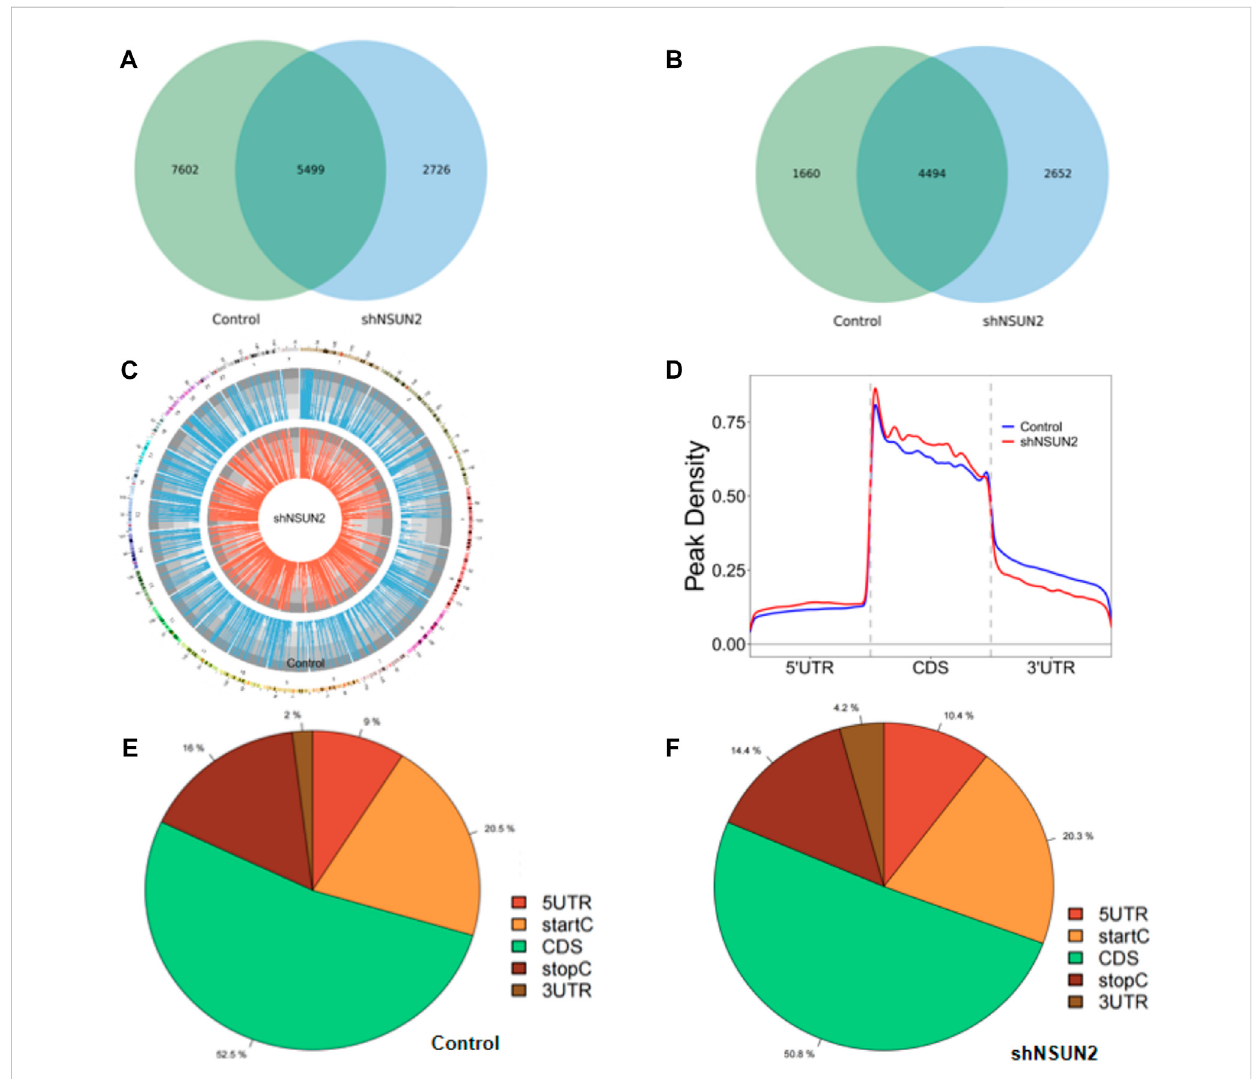
FIGURE 2 Characteristics of m5C peaks in HCT15 cell and sh-NSUN2 HCT15 cell (A) Venn diagram of m5C peaks in HCT15 cell and sh-NSUN2 HCT15 cell. (B) Venn diagram of m5C genes in HCT15 cell and sh-NSUN2 HCT15 cell. (C) Visualization of m5C at the chromosome level in HCT15 cell and sh-NSUN2 HCT15 cell (D) Accumulation of the region of average m5C peaks along all transcripts in HCT15 cell and sh-NSUN2 HCT15 cell. (E,F) Pie chart of the source of methylated mRNA in HCT15 cell and sh-NSUN2 HCT15